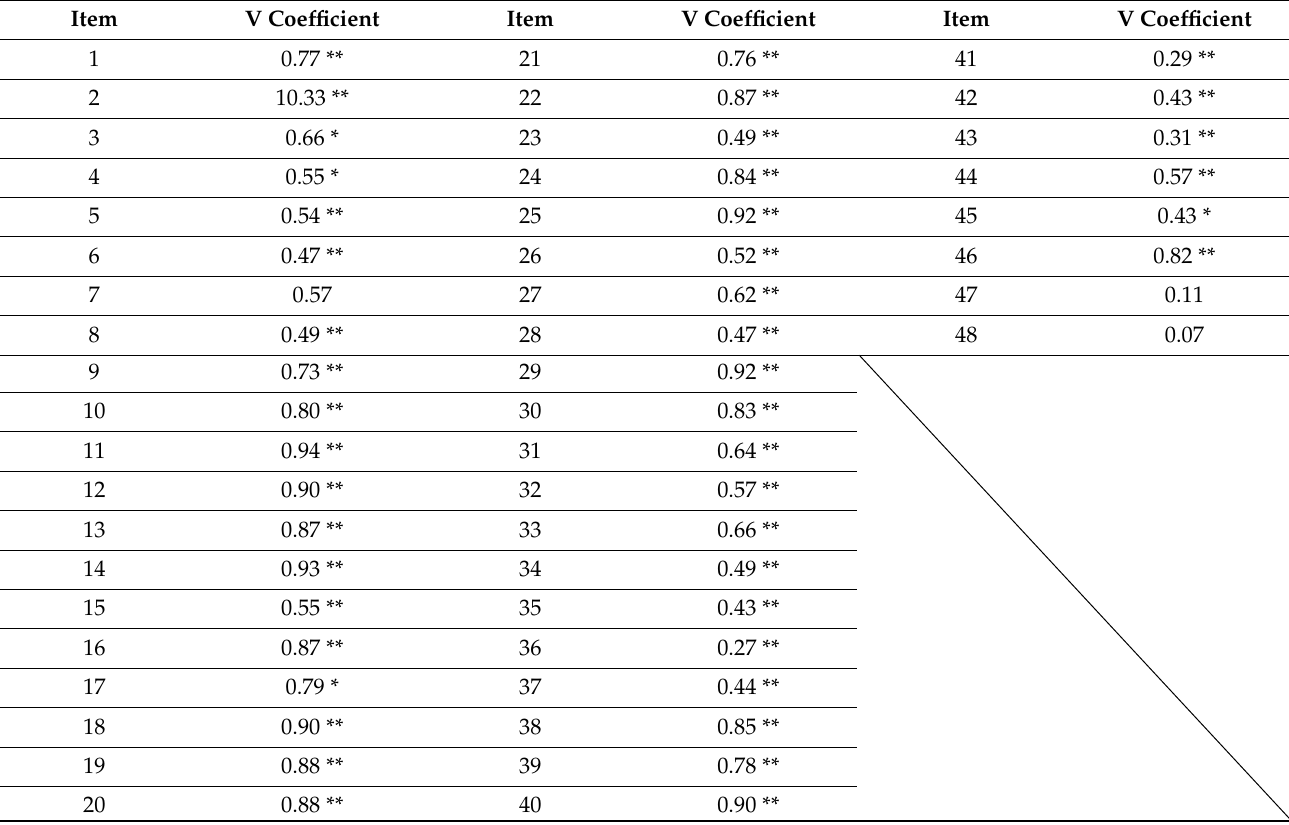
Table 4. Items assessing Taekwondo athletes’ sport psychological skills.